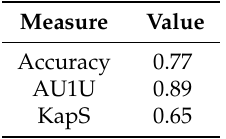
Table 3. Results of predictions on the validation data